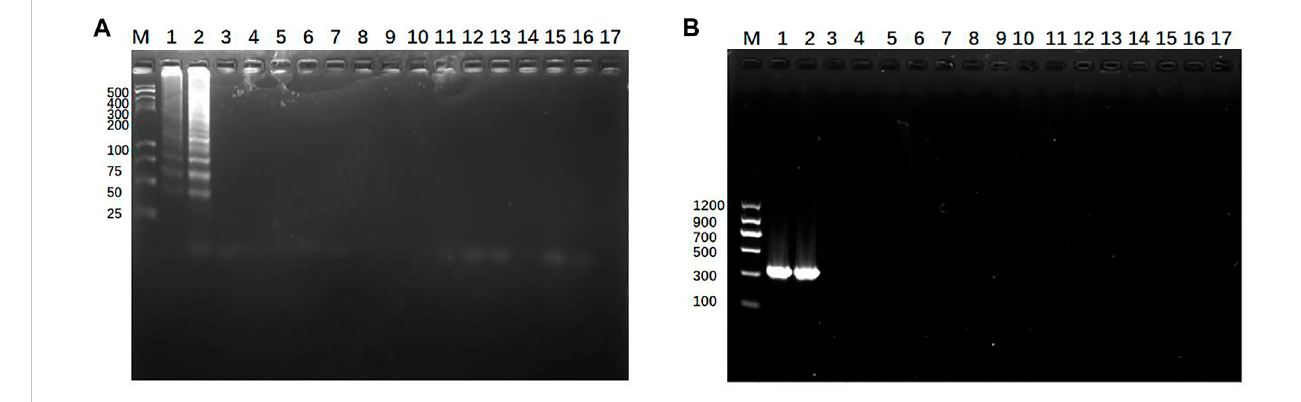
TABLE 3 Comparison of SEA-ICTS and PCR-ICTS results with PCR-GE and Vitek 2 compact results ( mdh ). NO. Sample type and species NAA-ICTS NAA-GE Vitek 2 compact SEA-ICTS PCR-ICTS SEA-GE PCR-GE Klebsiella pneumoniae (ATCC 700603) 2 – 20 Klebsiella pneumoniae (19 clinical isolates of infants)